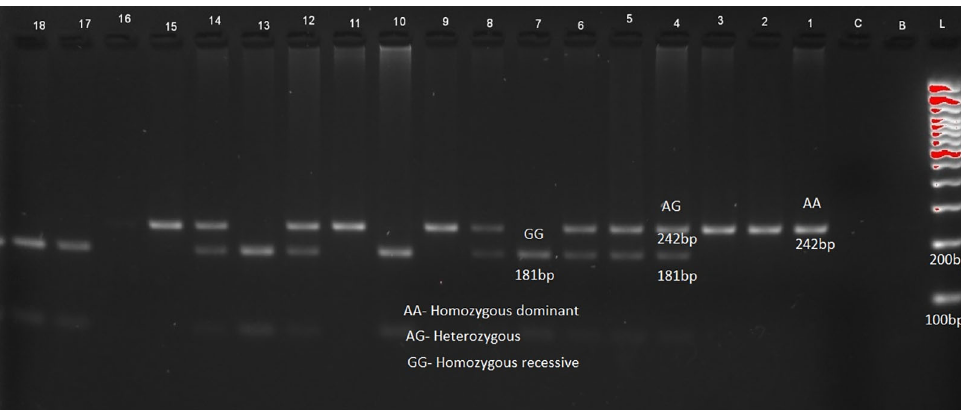
Figure 1. Sample pattern of distribution of alleles of leptin gene (LEP).